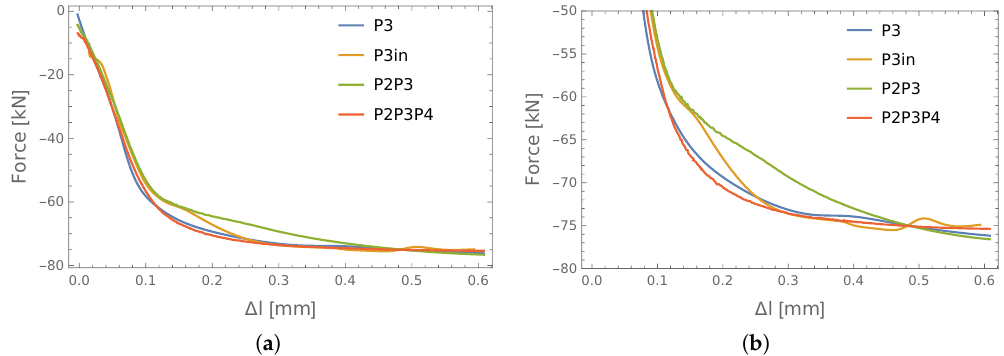
Figure 13. The result of the prediction forces with respect to the P3 connection: ( a ) comparison of the studied input vector scenarios; ( b ) details of ( a